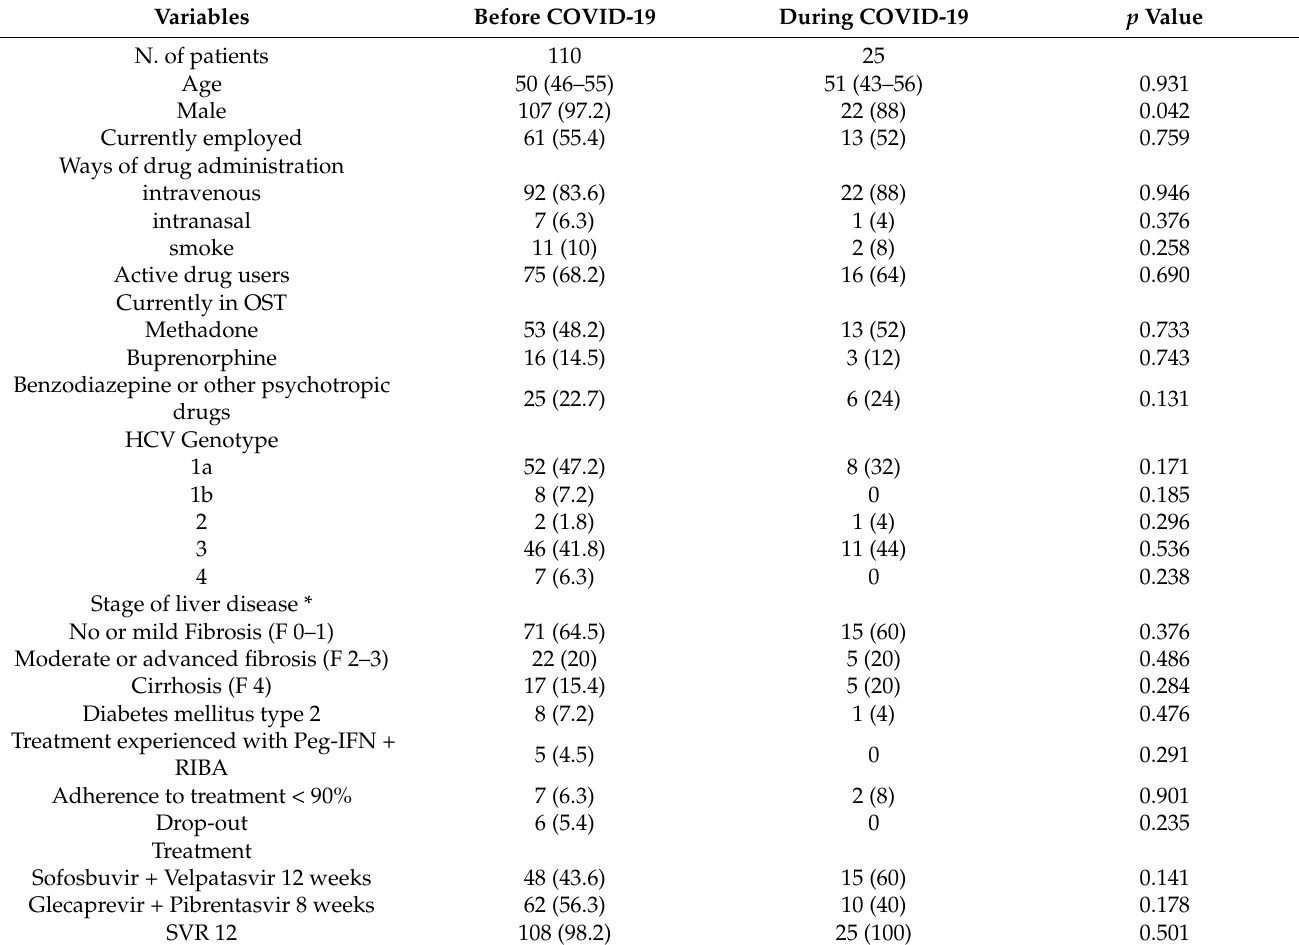
Table 3. Clinical features of PWUDs matched for period of